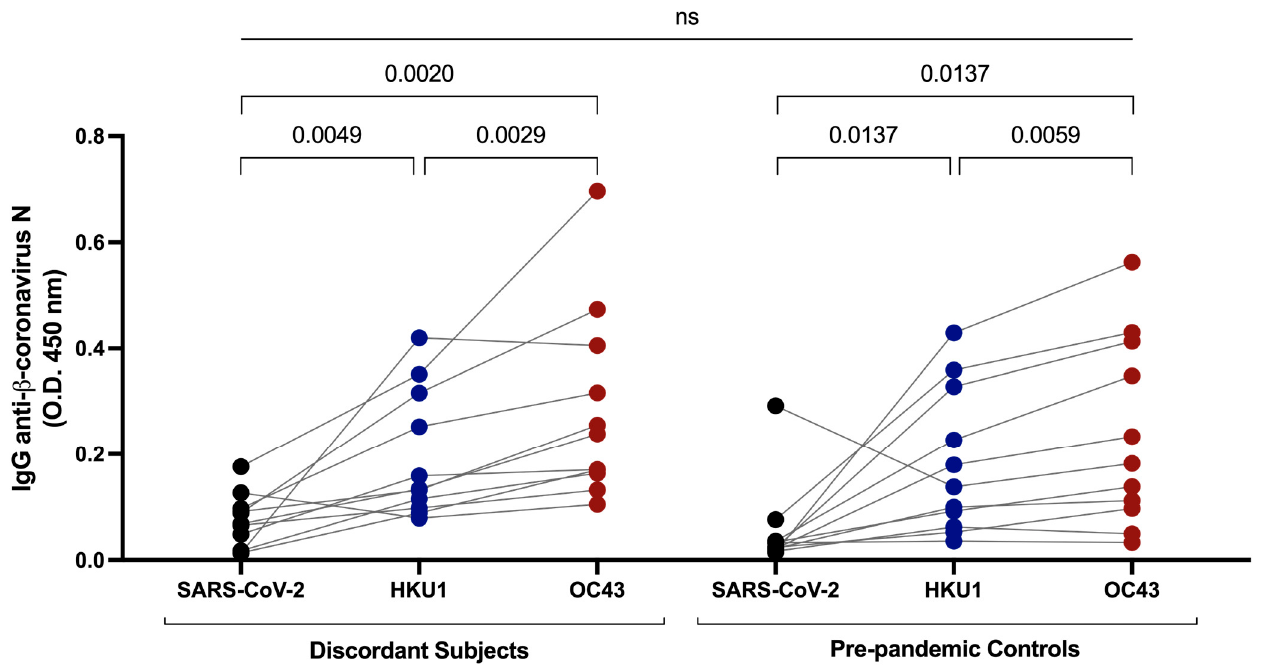
Figure 3. Measurement of cross-reactive antibodies against SARS-CoV-2 and common β -coronavirus N proteins by ELISA. IgG anti- β -coronavirus N antibodies against SARS-CoV-2, HKU1, and OC43 in plasma samples from the discordant cases were measured and compared to pre-pandemic plasma samples from age- and sex-matched controls. Black, blue and red shaded dots represent the IgG response against SARS-CoV-2, HKU1 and OC43 N proteins respectively. The probability of a signif- icant difference between groups was calculated by Mann–Whitney test and responses to different N proteins compared by Wilcoxon signed rank test, with p values above lines spanning the groups compared. There was no significant difference between the discordant and pre-pandemic